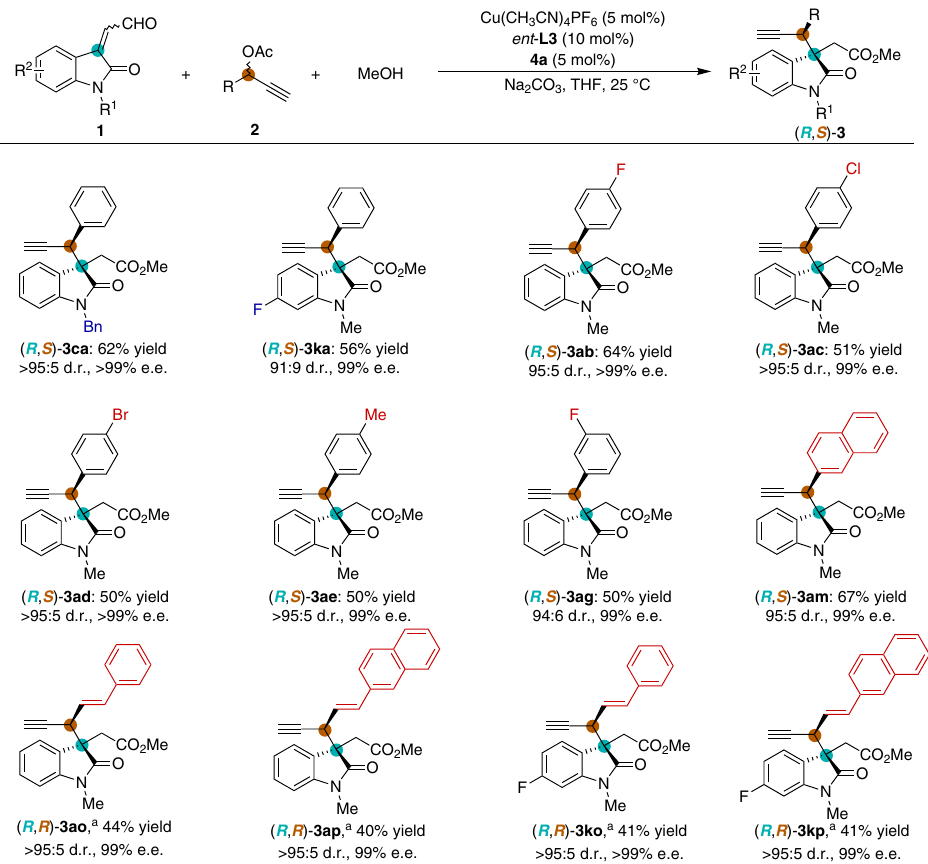
Fig. 4 Demonstration of diastereodivergence. Reaction conditions: Cu(CH 3 CN) 4 PF 6 (5 mol%) and pyridine bis(oxazoline) ligand ent - L3 (10 mol%) were stirred in THF (0.5 mL) at 25 °C for 1 h, then NHC precatalyst 4a (5 mol%), 1 (0.15 mmol), 2 (0.1 mmol), MeOH (0.5 mmol), Na 2 CO 3 (0.1 mmol) and THF (0.5 mL) were added to the reaction mixture and stirred for 12 h under N 2 . Diastereomeric ratio (d.r.) was determined by 1 H NMR spectroscopic analysis. Isolated yields. The enantiomeric excess (e.e.) was determined by HPLC. a Cu(CH 3 CN) 4 PF 6 (7.5 mol%), 2,6-bis((4 R ,5 S )-4,5-diphenyl-4,5-dihydrooxazol- 2-yl)pyridine L5 (15 mol%), NHC precatalyst 4a (7.5 mol%), 1 (0.15 mmol), styryl-substituted propargylic benzoates 2 (0.1 mmol), Na 2 CO 3 (0.2 mmol), and DCM (1.0 mL) were used, at 15 °C.